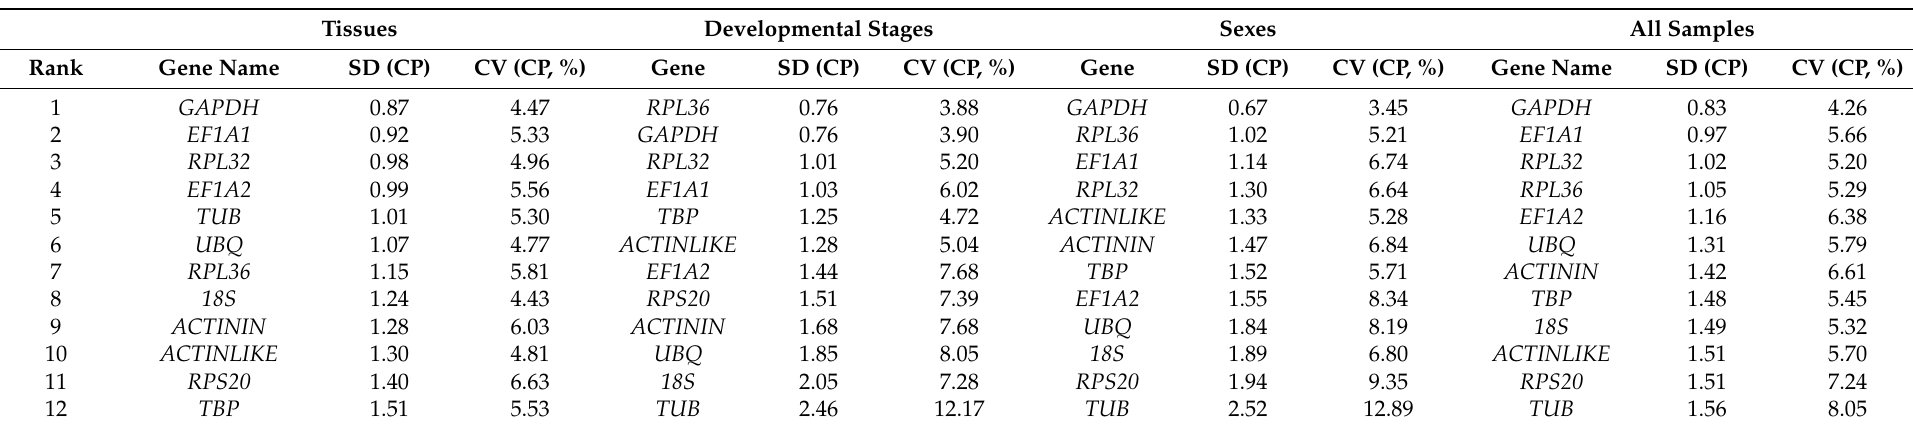
Table 3. Stability of gene expression in Glenea cantor , as ranked by